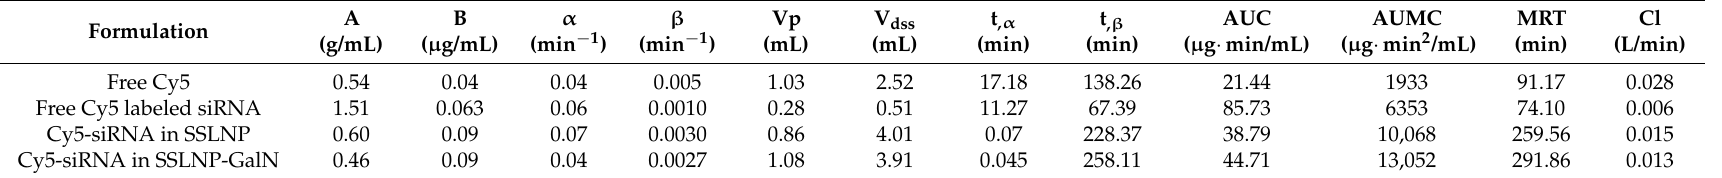
Table 2. Pharmacokinetic parameters of different siRNA